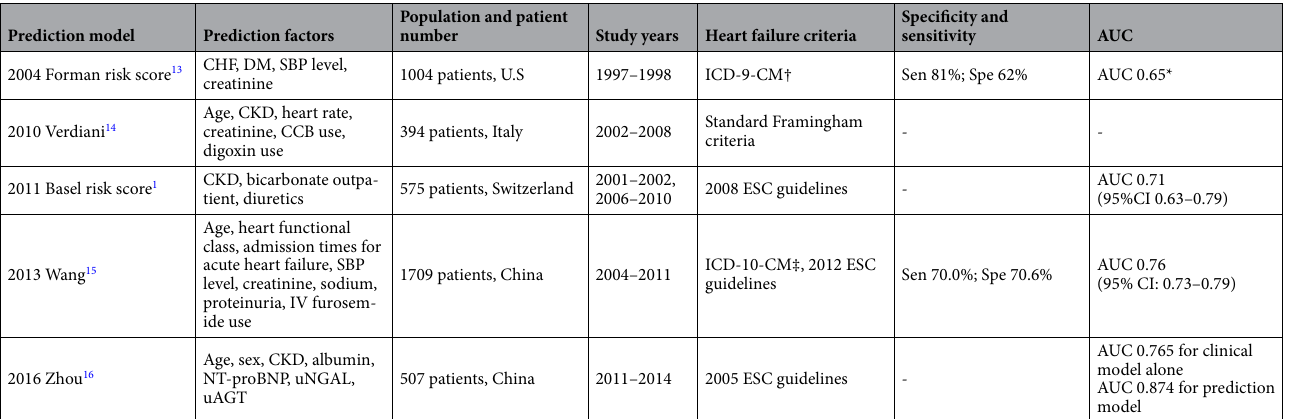
Table 1. Existing prediction models for acute kidney injury in patients with acute heart failure. AUC area under the receiver operating characteristic curve; CCB calcium channel blocker; CHF congestive heart failure; CKD chronic kidney disease; DM diabetes mellitus; ESC European Society of Cardiology; ICD-9-CM International Classification of Diseases, ICD-10-CM International Classification of Diseases; tenth Revision, Clinical Modification; IV: intravenous therapy; NT-proBNP N-terminal pro-brain natriuretic peptide; SBP systolic blood pressure; uAGT urinary angiotensinogen; uNGAL urinary neutrophil gelatinase-associated lipocalin; U.S. United State. *AUC is not calculated in original article. AUC 0.65 was documented by 2011 Basel risk score and 2013 Wang study. † Heart failure was identified using ICD-9-CM codes 428.0,